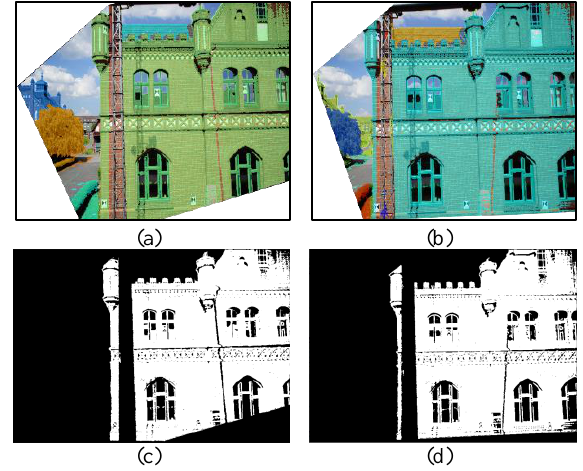
Figure 7. The segmentation result before Grabcut. (a) segmented first image using the first image pair, (b) segmented second image using the second image pair, (c) binary map for the segmentation of the first image, (d) binary map for the segmentation of the second image.